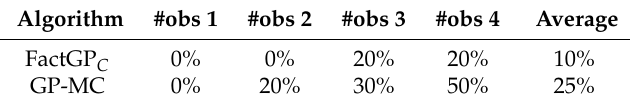
Table 2. Average collision rate with trials (%) of FactGP C with 20% basis vectors and GP-MC.